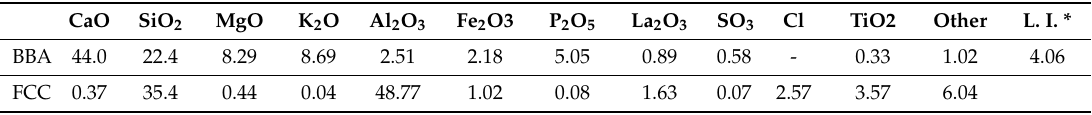
Table 1. Oxide composition of initial aluminosilicate materials: zeolitic waste (FCC) and biomass bottom ash (BBA) (according to XRF), wt. %.